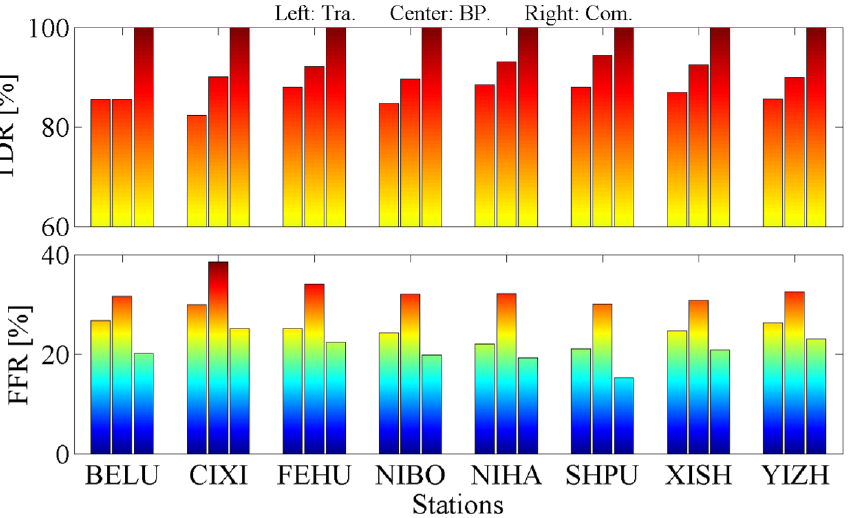
Figure 9. Statistics of TDR and FFR of traditional, BP-NN and combined rainfall early warning models at different stations.